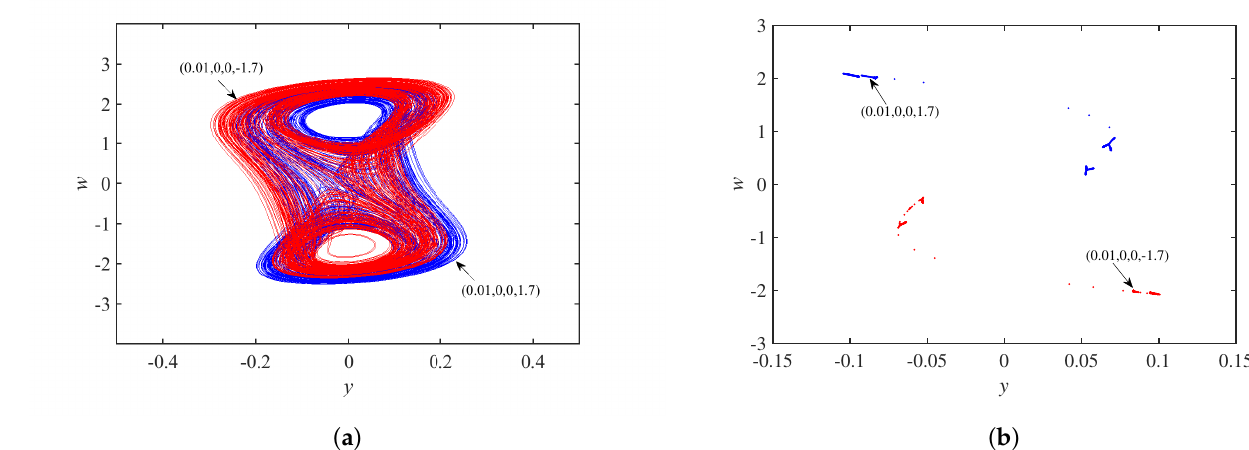
Figure 18. When ϕ ( 0 ) = ± 1.7: ( a ) coexisting double-scroll attractors; ( b ) Poincaré